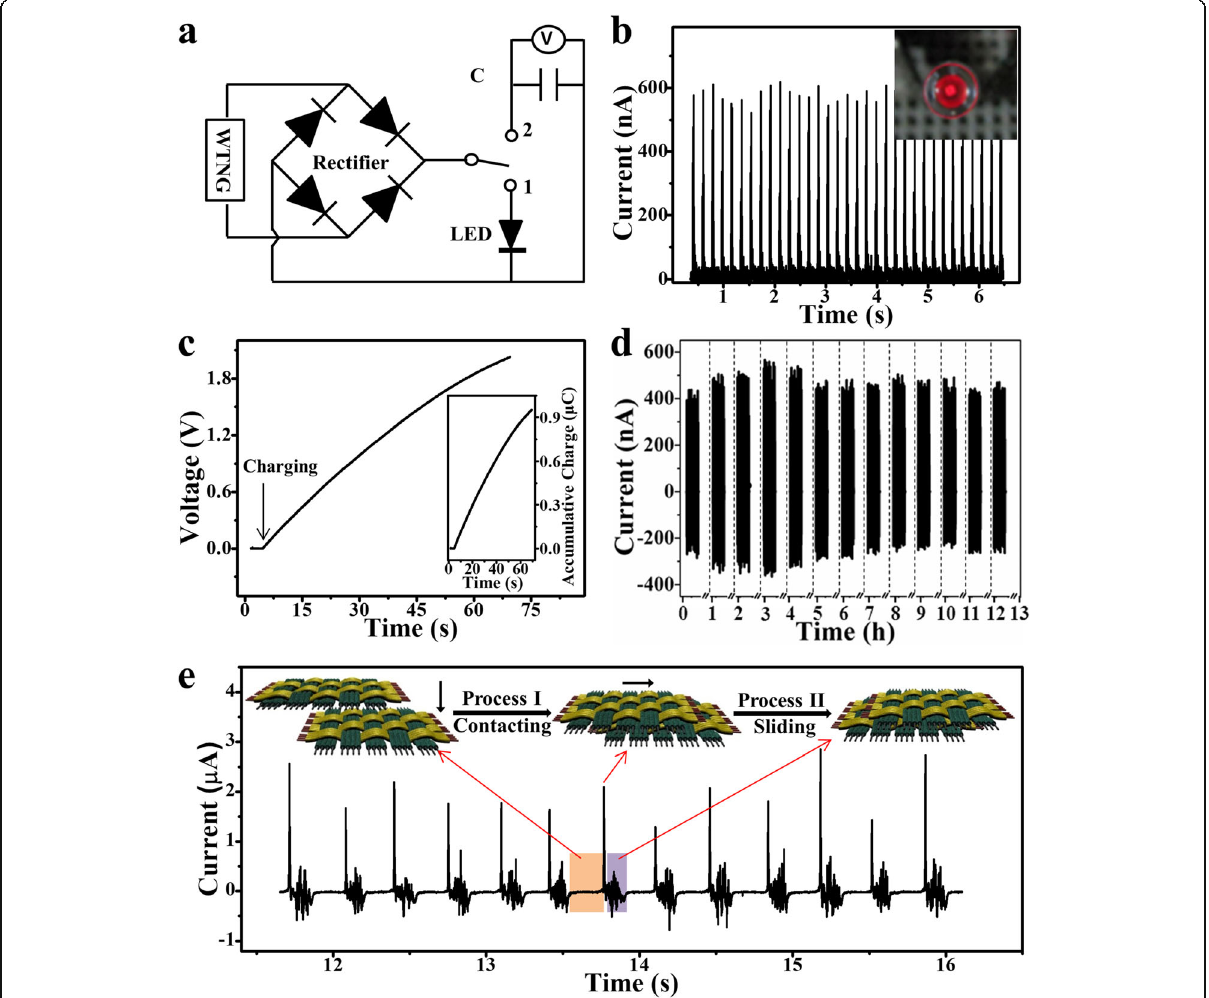
Fig. 5 Application of the 2DW-WTNG. a Rectification circuit with two branch circuits at the output terminal. b Rectified output current signal. The inset is an optical image of a red LED powered by the rectified current signal. c Charging curve for a 0.47 μ F commercial capacitor charged by the rectified current. The insert is the corresponding output charges stored in the capacitor. d Output current of the 2DW-WTNG working continuously for 12 h. e Output current of the 2DW-WTNG working in two different working modes, demonstrating the versatility of the 2DW- WTNG in scavenging human body motion energy. The working process is shown in the